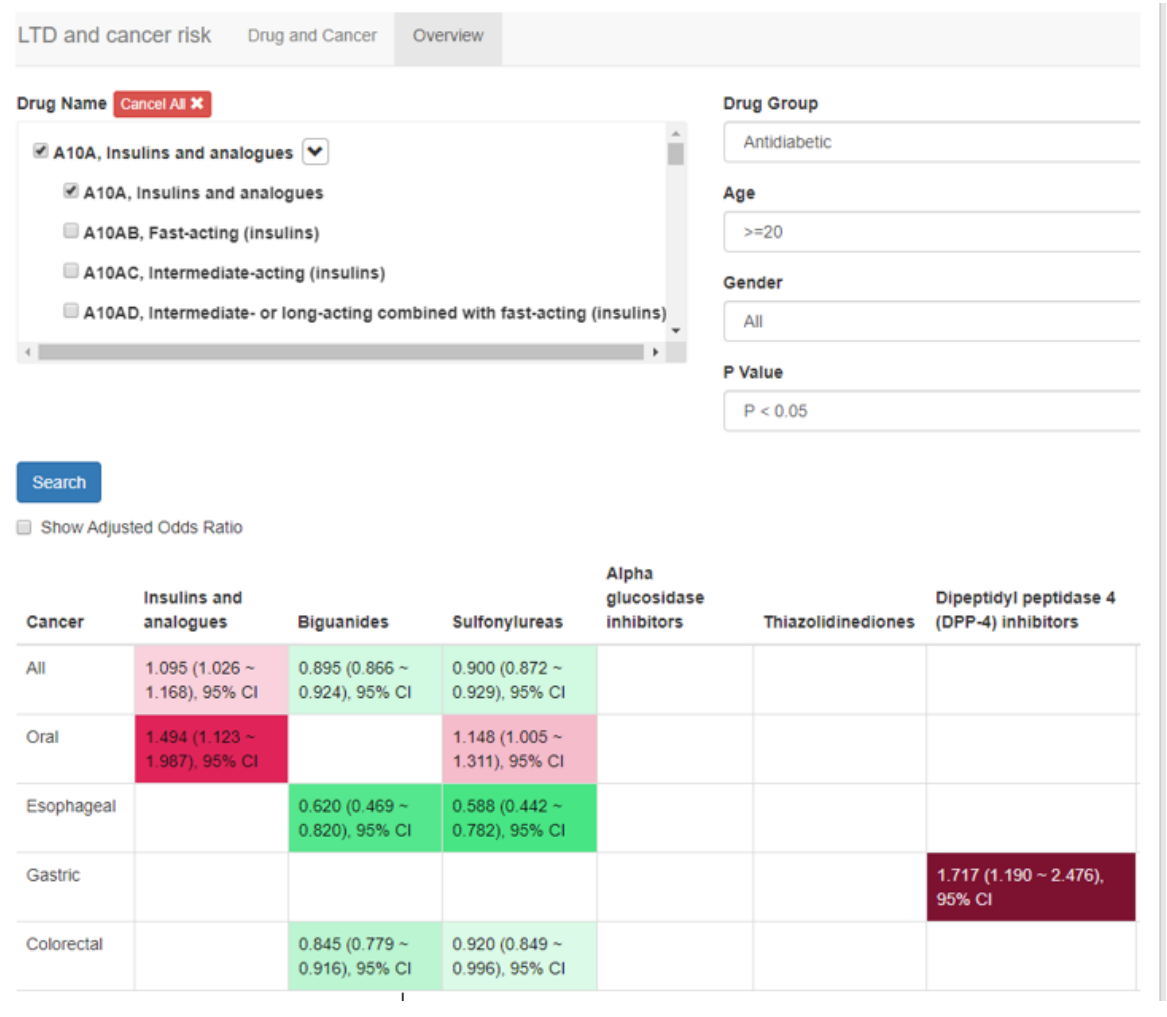
Figure 4. Display of